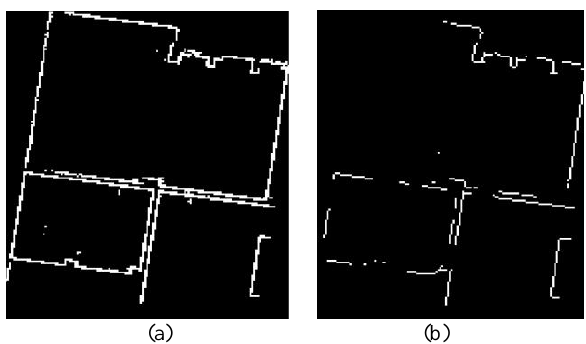
Figure 6. Optimal section selection results. (a) Extracted sections of the offset solution; (b) the median